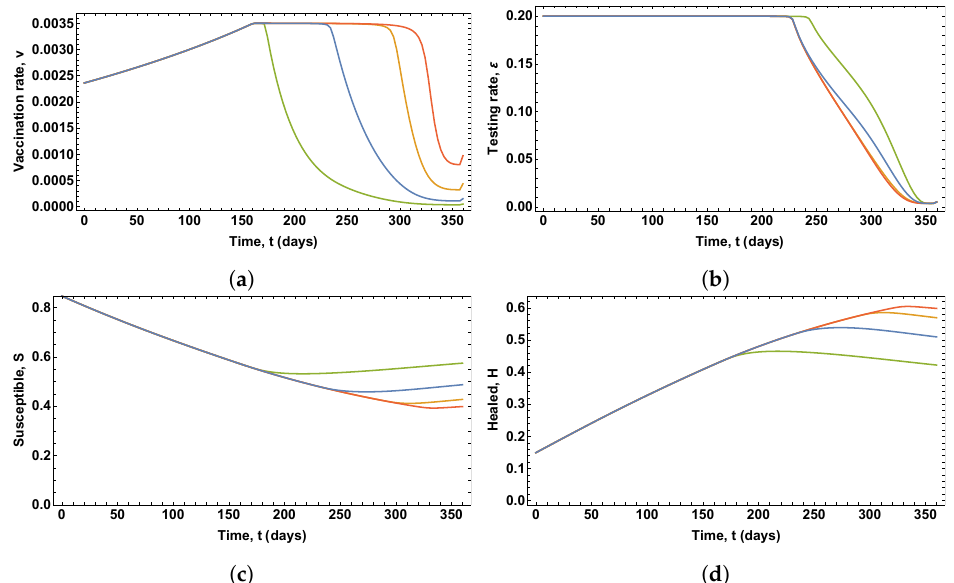
Figure 10. Optimal policies and proportions of people in each compartment obtained assuming C 2 = 0.001 (red), C 2 = 0.01 (orange), C 2 = 0.1 (blue), and C 2 = 1 (green), with fixed parameters C 1 = 1 and C 3 = 0.0001: ( a ) Optimal vaccination rates. ( b ) Optimal testing rates. ( c ) Susceptible people. ( d ) Healed people.